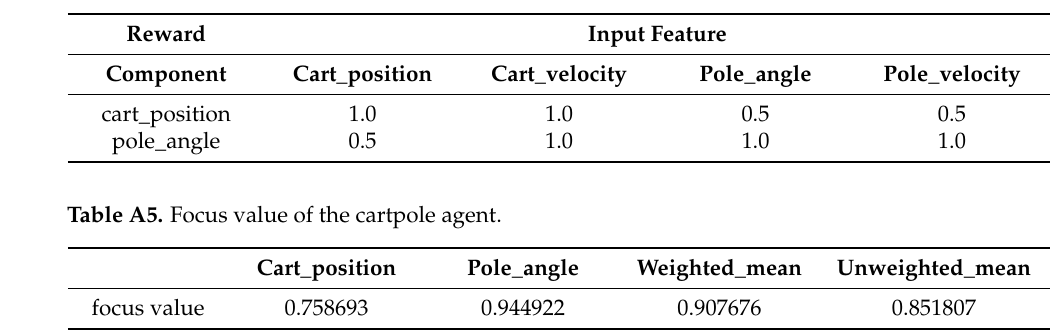
Table A4. Relevance table for the cartpole agent.